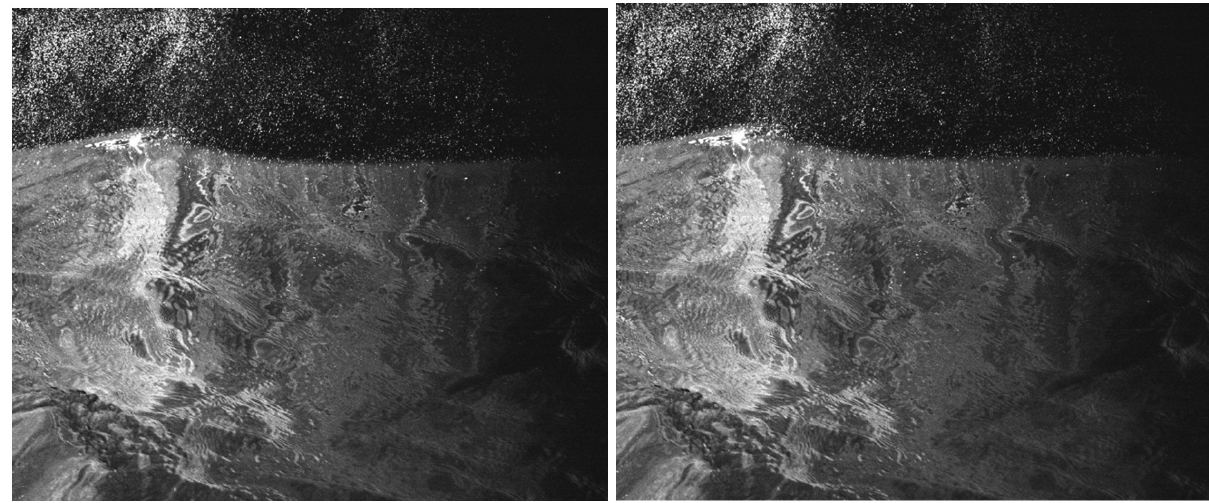
Figures 12a and 12b. Two sequential images of cross-sectioned waves, imaged with laser light. Courtesy of Marc